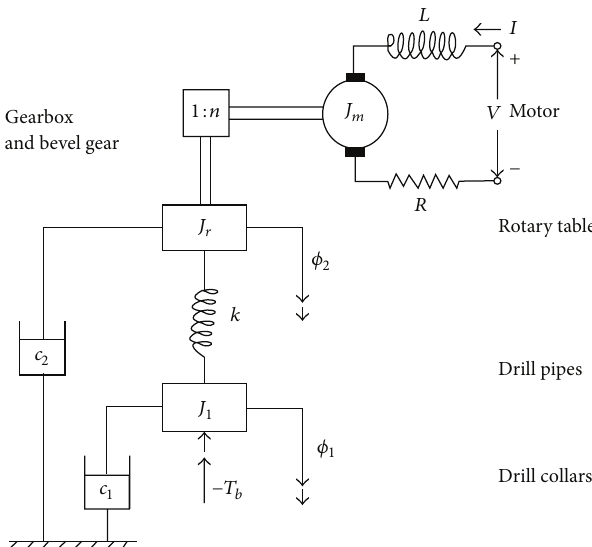
Figure 2: Representation of drill string/drive system with mechan- ical and electrical components